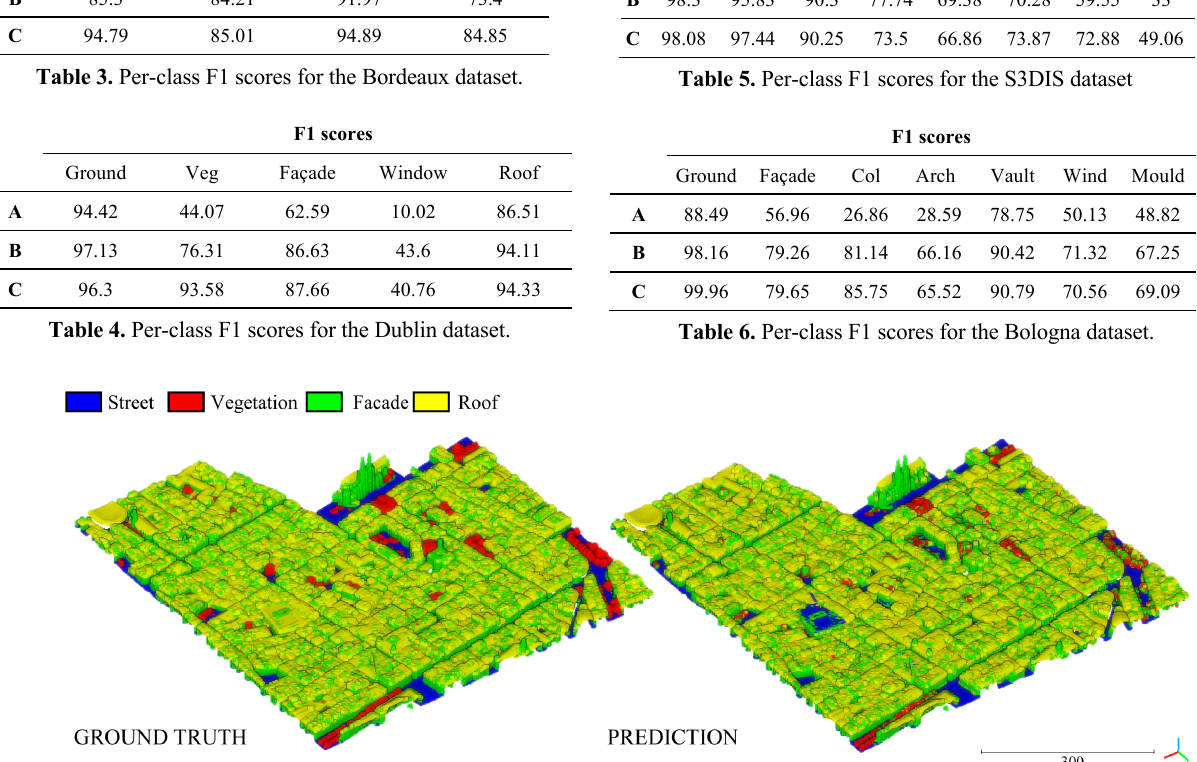
Figure 7. Visual comparison between the hand-annotated Bordeaux dataset (left) and the prediction achieved using the proposed method